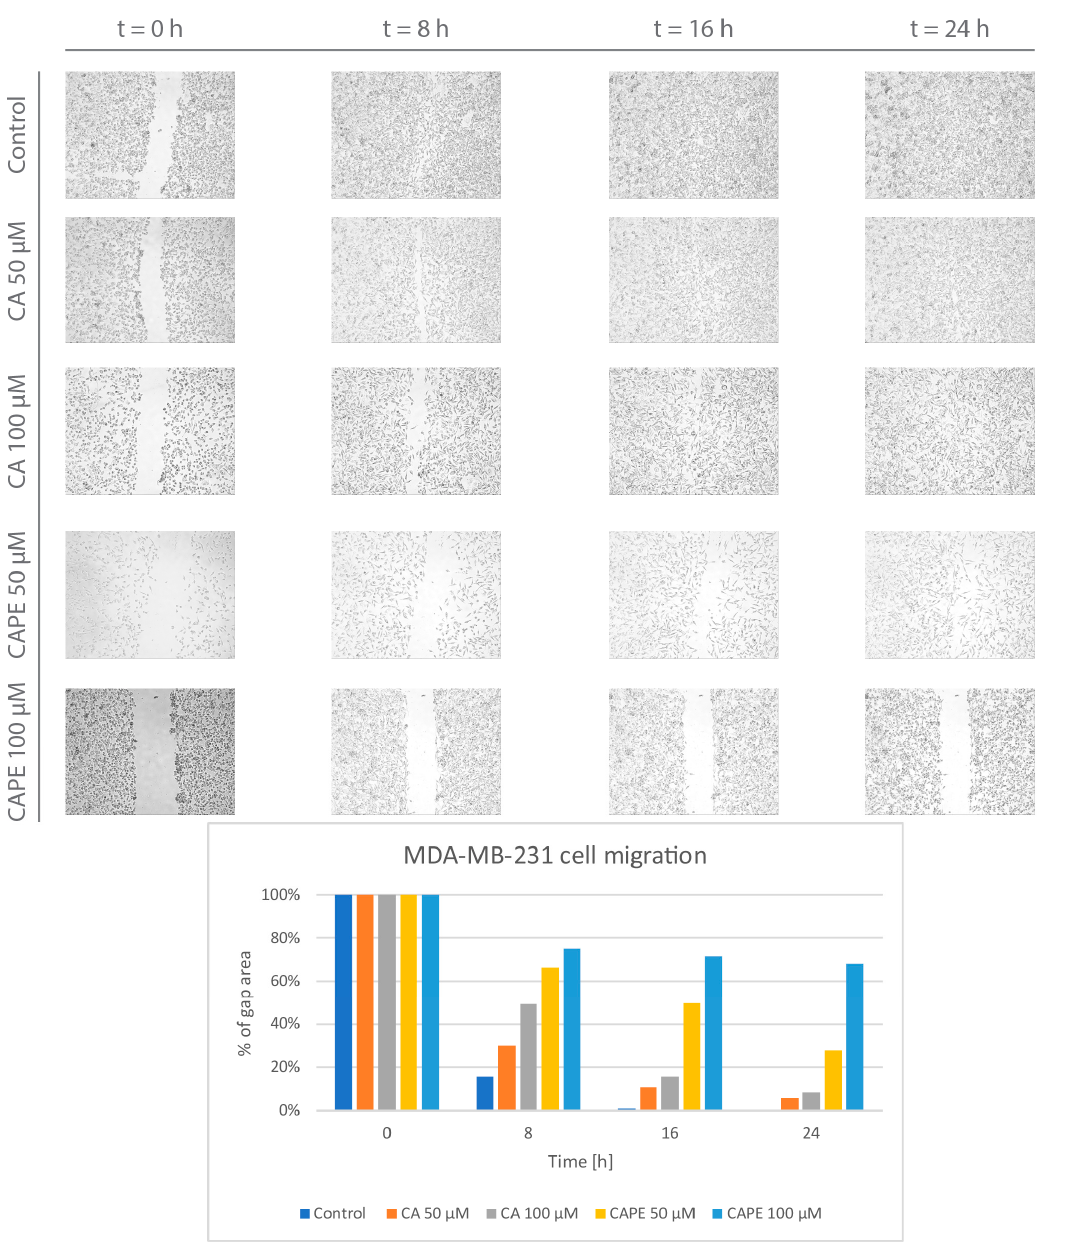
Figure 5. Caffeic acid (CA) and caffeic acid phenethyl ester (CAPE) at concentrations of 50 µM and 100 µM promote an inhibitory migration effect on MDA-MB-231 cells. There was a visible dose-dependent effect. The gap did not reach full closure for either agent. Comparison of these two substances shows CAPE has a greater influence on cell migration inhibition in MDA-MB-231 than CA. CAPE treatment with a dose of 100 µM demonstrated that the wound area basically remained unchanged over time. CAPE created a 'barrier’ that was practically impassable and impenetrable by the MDA-MB-231 cells. The cell migration factor was performed by monolayer gap closure migration assay and embedded by free ImageJ software. The results are presented as the gap area in relation to the area value of the initial scratch, after 8 h, 16 h, and 24 h of observation.